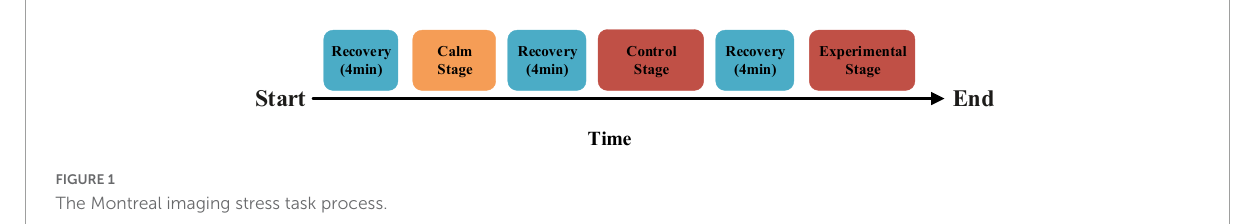
FIGURE1 The Montreal imaging stress task process.